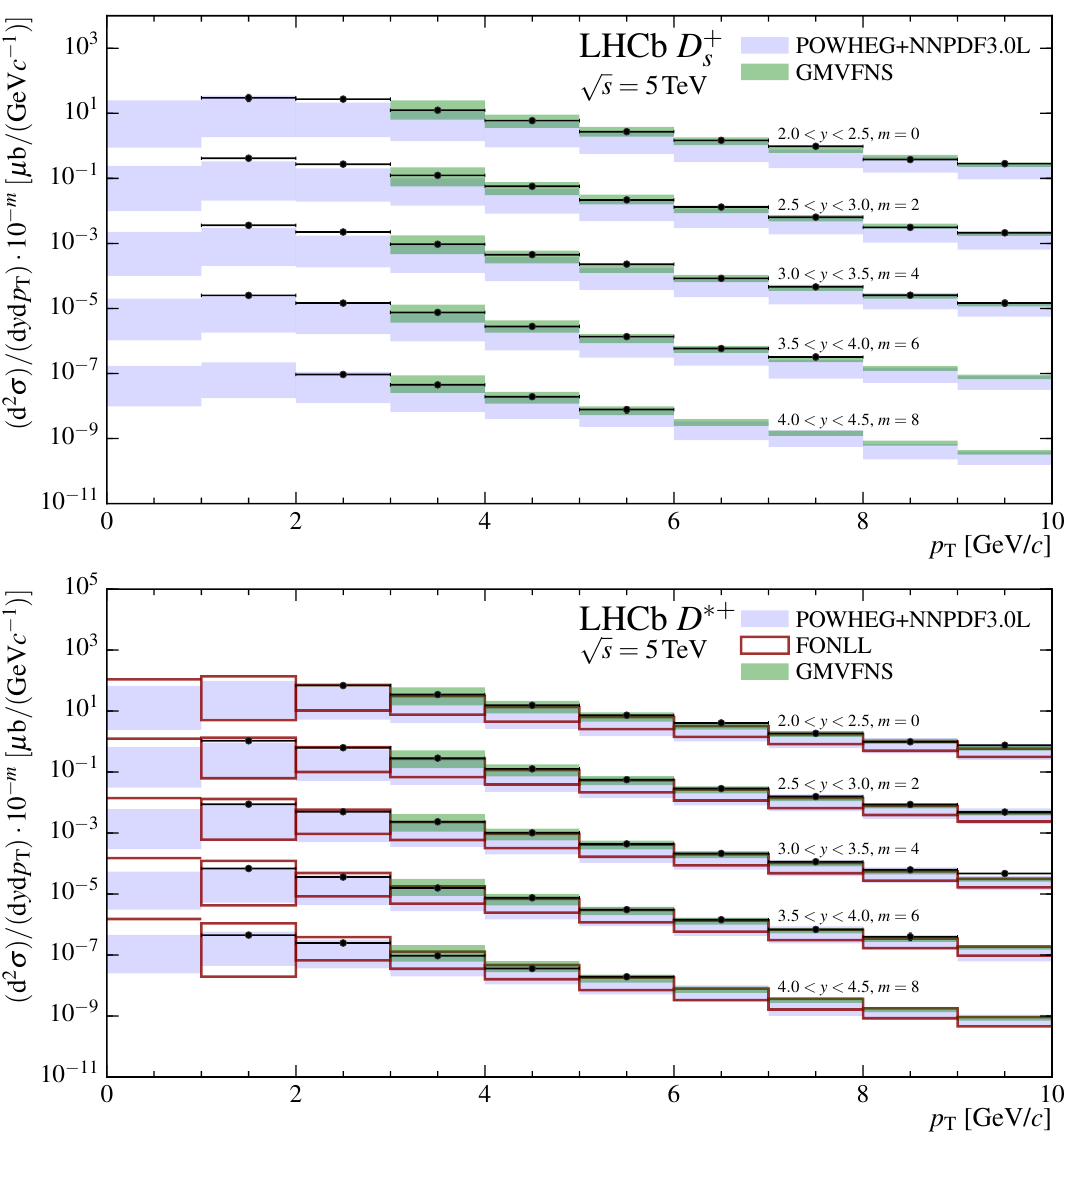
Figure 6. Measurements and predictions for the absolute prompt (top) D + cross-sections at p s = 5 TeV. Each set of measurements and predictions in a given rapidity bin is o(cid:11)set by a multiplicative factor 10 (cid:0) m , where the factor m is shown on the plots. The boxes indicate the 1 (cid:27) uncertainty band on the theory predictions, where only the upper edge is shown if the (cid:6) uncertainty exceeds two orders of magnitude.